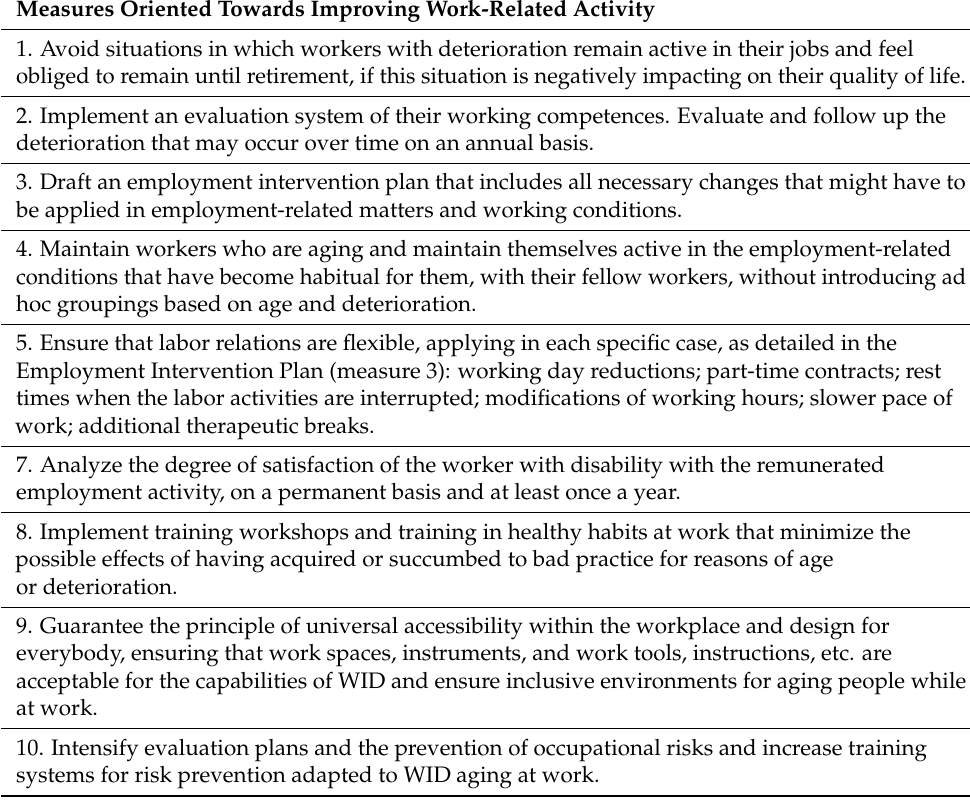
Table 4. Measures from line of action 2, referring to the work environment.